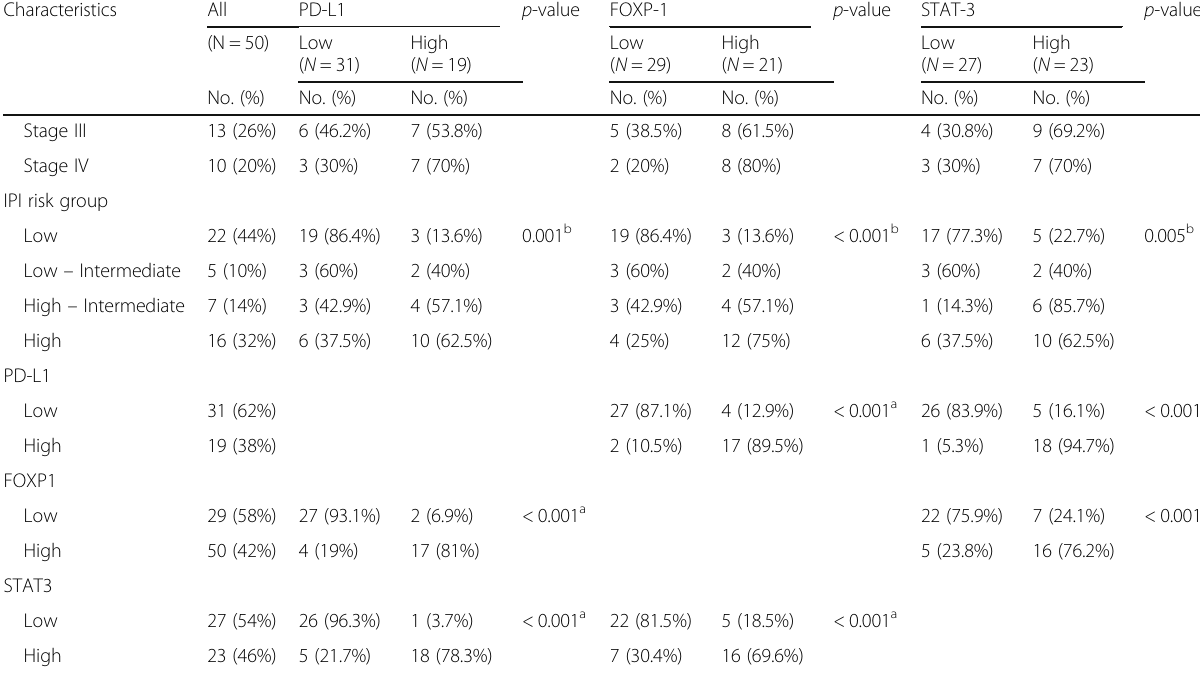
Table 2 Correlation between clinicopathological features, PDL-1, FOXP-1, STAT-3 expression in our patients (Continued)